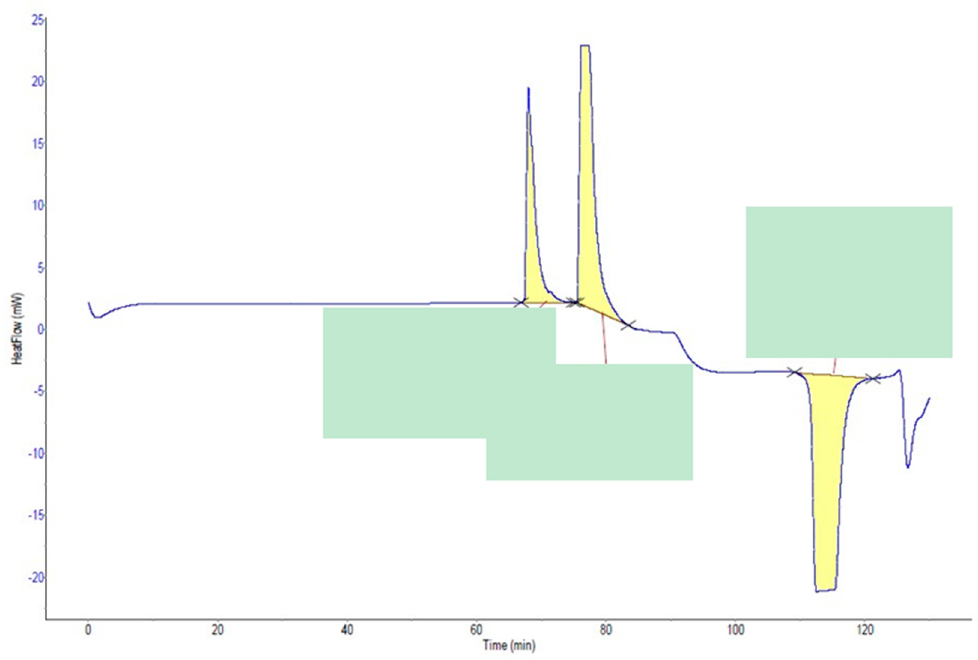
Figure 6. Typical heat flow profile with the presence of hydrate inhibitor at 10 MPa.